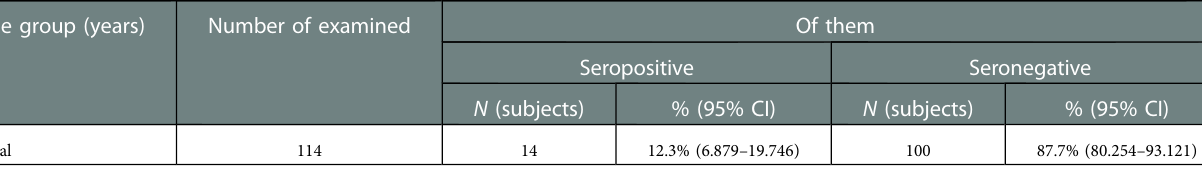
TABLE 2 IgA blood serum levels to pertussis in pregnant women. Age group (years)